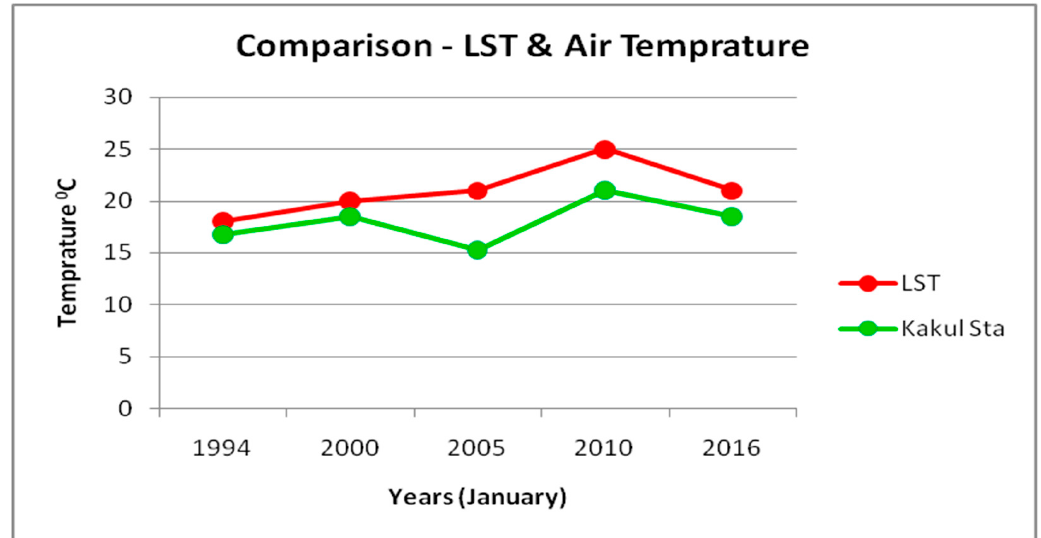
Figure 17. Comparison—LST and air temperature—Jan.